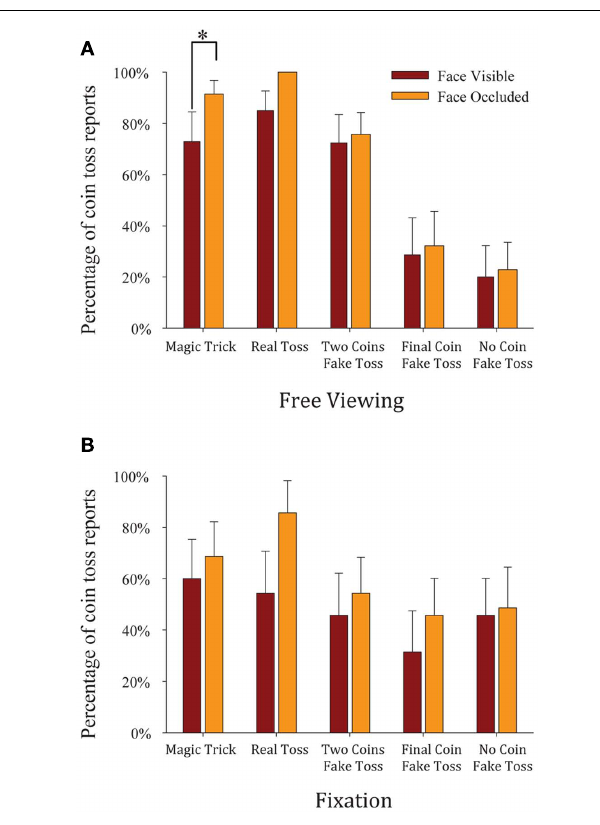
FIGURE 5 |Average percentage of coin toss reports according to type of performance. (A) Free-viewing condition. (B) Fixation condition. Error bars represent SEM across subjects ( N = 8). *Paired t -test, p < 0.05.